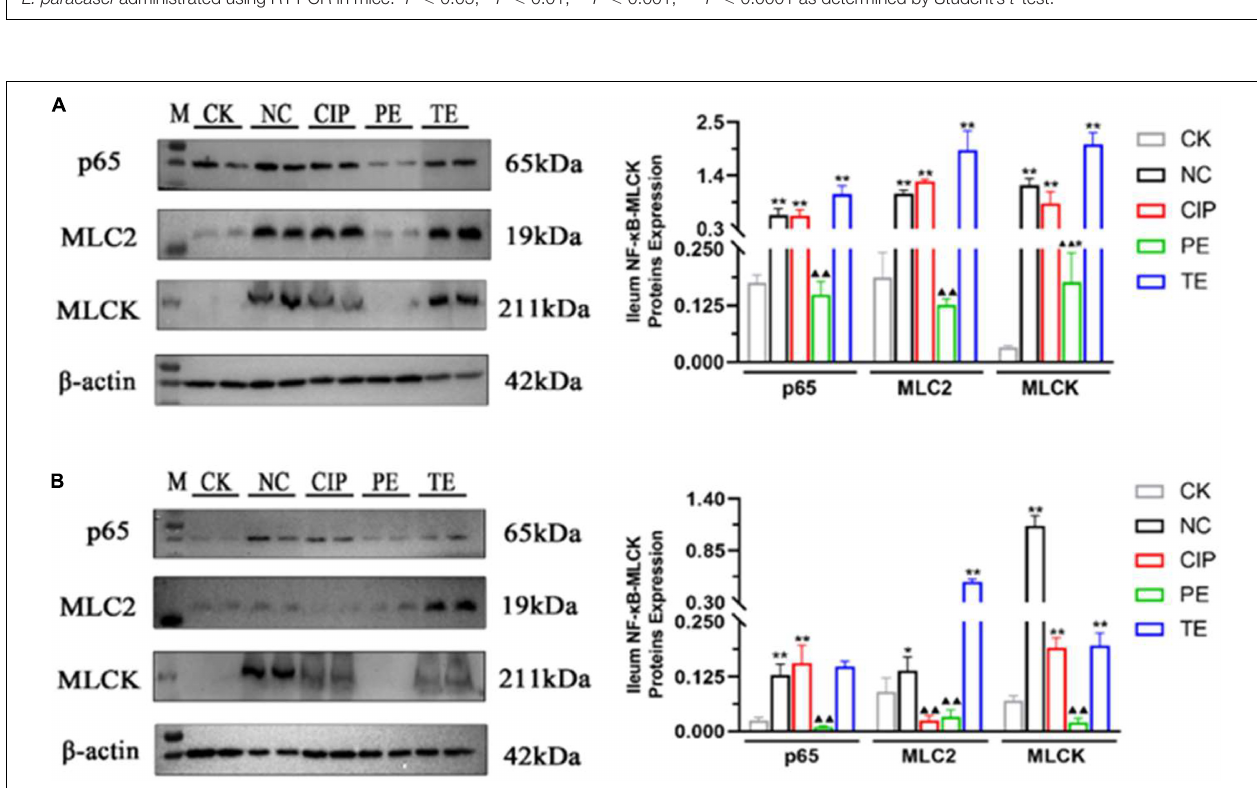
FIGURE 8 | Protein expression levels of I κ B α , p65, MLC2, MLCK and β -actin on days 8 (A) and 15 (B) . *Representative compared with CK group. * P < 0.05, ** P < 0.01. (cid:78) Representative compared with NC group. (cid:78) P < 0.05, (cid:78)(cid:78) P < 0.01 as determined by Student’s t -test.